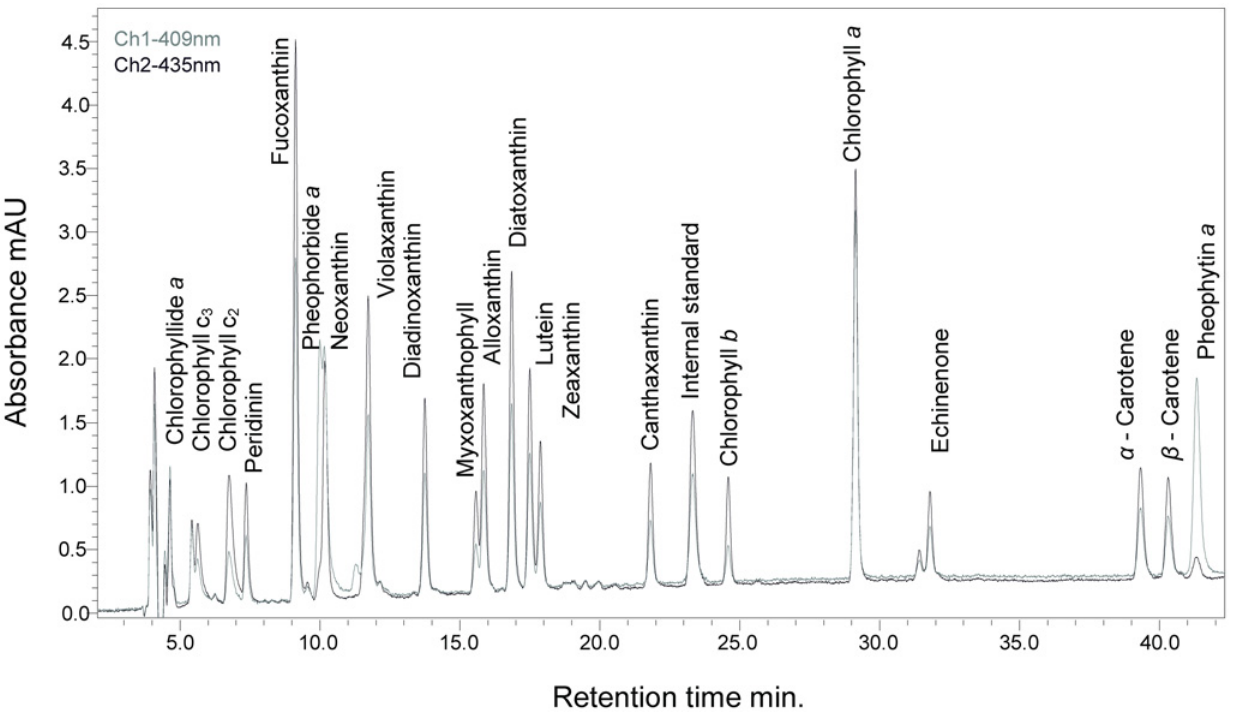
Fig 2. Typical chromatogram of phytoplankton pigment standards. Key pigments, including zeaxanthin and lutein, are well separated.